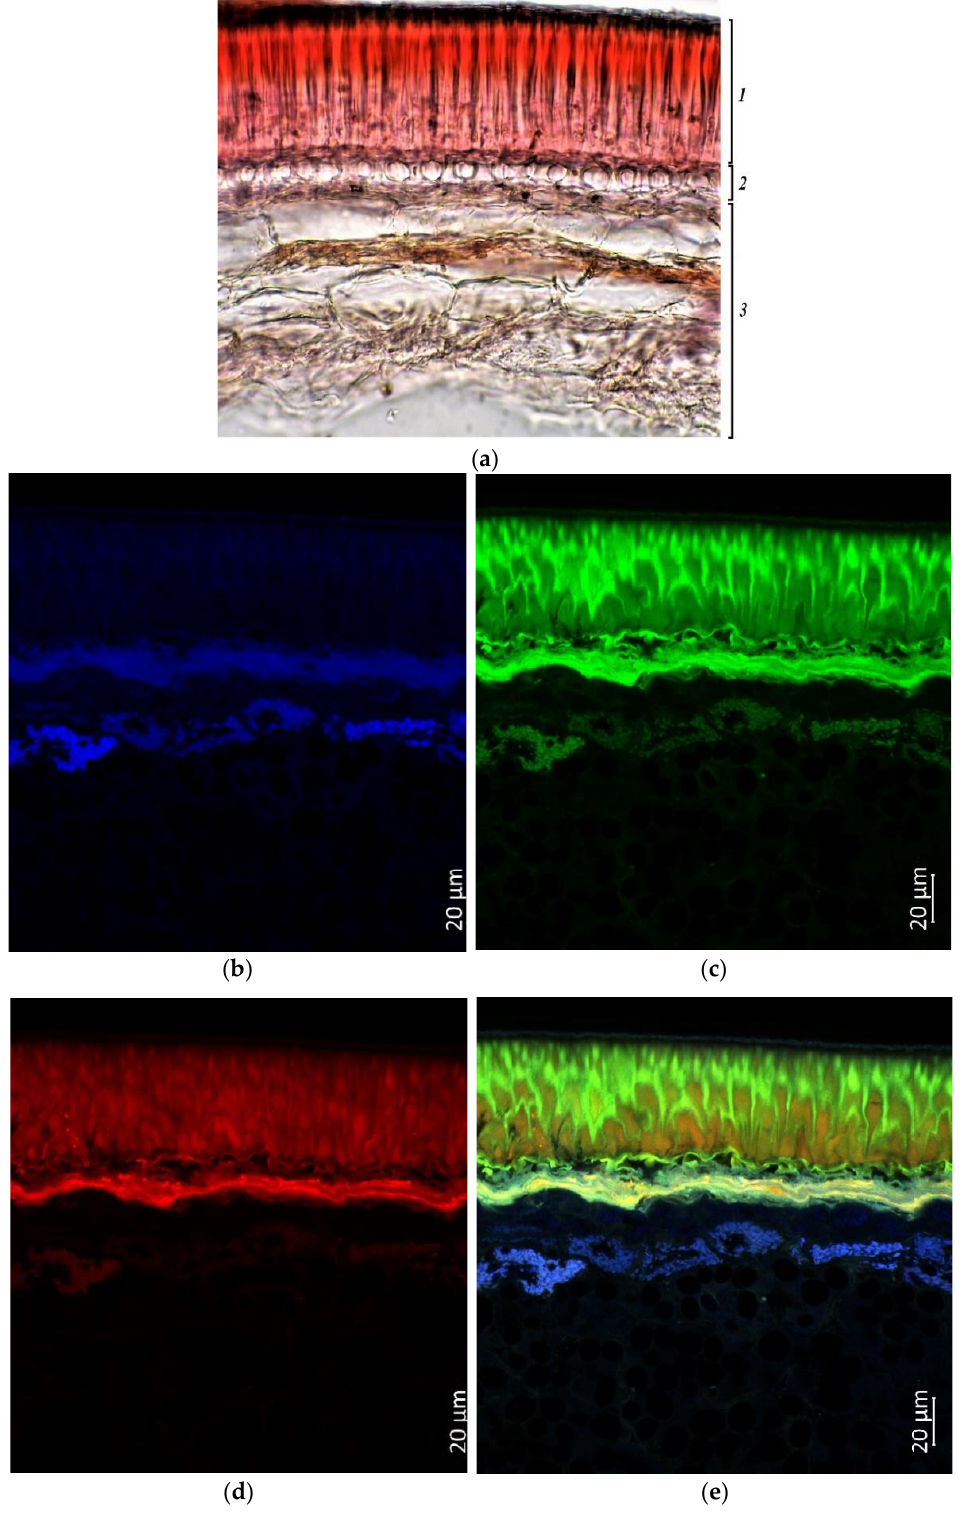
Figure 11. V. unguiculata accession k-642: ( a ) — seed coat structure, light microscopy (1 — palisade Figure 11. V . unguiculata accession k-642: ( a )—seed coat structure, light microscopy (1—palisade layer, 2 — hypoderma, 3 — parenchyma); ( b – e ) transverse section of the seed, confocal microscopy, layer, 2—hypoderma, 3—parenchyma); ( b – e ) transverse section of the seed, confocal microscopy, ( b ) — excitation 405 nm with the emission in 400 – 475 nm (blue), ( c ) — excitation 488 nm with the ( b )—excitation 405 nm with the emission in 400–475 nm (blue), ( c )—excitation 488 nm with the emission in 500 – 545 nm (green), ( d ) — excitation 488 nm with the emission in 620 – 700 nm (red), ( e ) — emission in 500–545 nm (green), ( d )—excitation 488 nm with the emission in 620–700 nm (red), merged. ( e